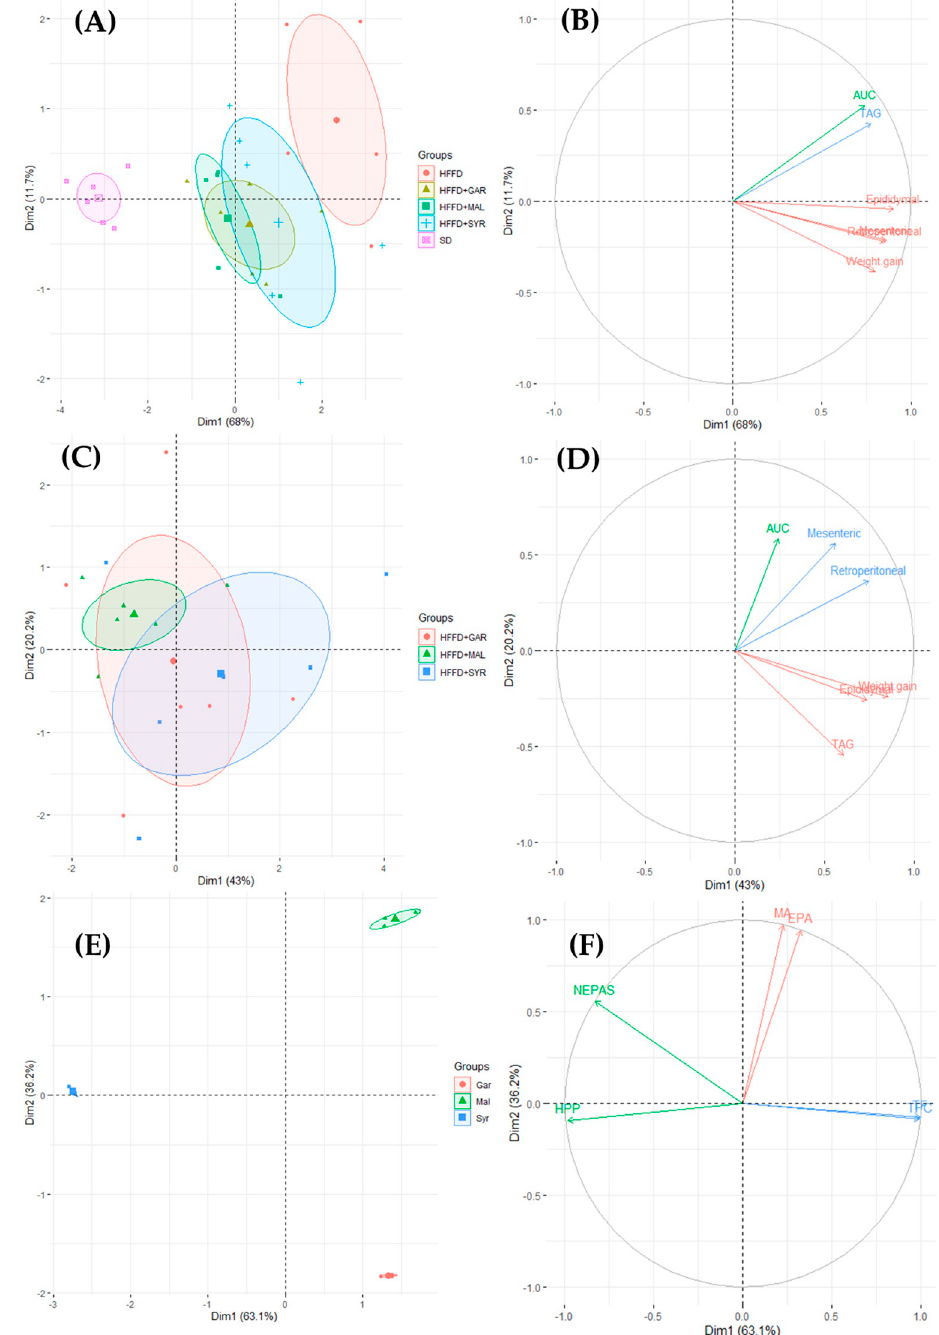
Figure 4. Principal component analysis (PCA) of physiological effects on rats fed a high-fat high- fructose diet supplemented with different varieties of grape pomace ( A , B ). Principal component analysis ( C ) and biplot ( D ) of the physiological effects on rats of supplementation of the high-fat high-fructose diet with different varieties of grape pomace. Principal component analysis ( E ) and biplot ( F ) of extractable and non-extractable polyphenol contents in different grape pomace varieties. AUC, area under the curve; EPA, extractable proanthocyanidins; GAR, Garnacha; HFFD, high- fat high-fructose diet; HPP, hydrolyzable polyphenols; MA, extractable monomeric anthocyanins; MAL, Malbec; NEPAs, non-extractable proanthocyanidins; STD, standard diet; SYR, Syrah; TAG, triacylglycerols; TF, total fl avonoids; TPC, total phenolics content. Finally, a partial least squares discriminant analysis was constructed to identify the extractable polyphenol discriminants of each grape pomace variety and their possible